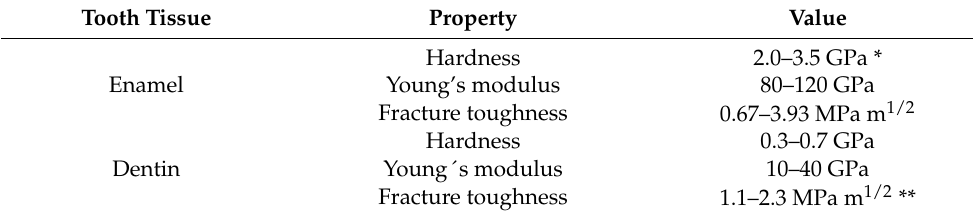
Table 2. Mechanical properties of enamel and dentin. Retrieved from [51].